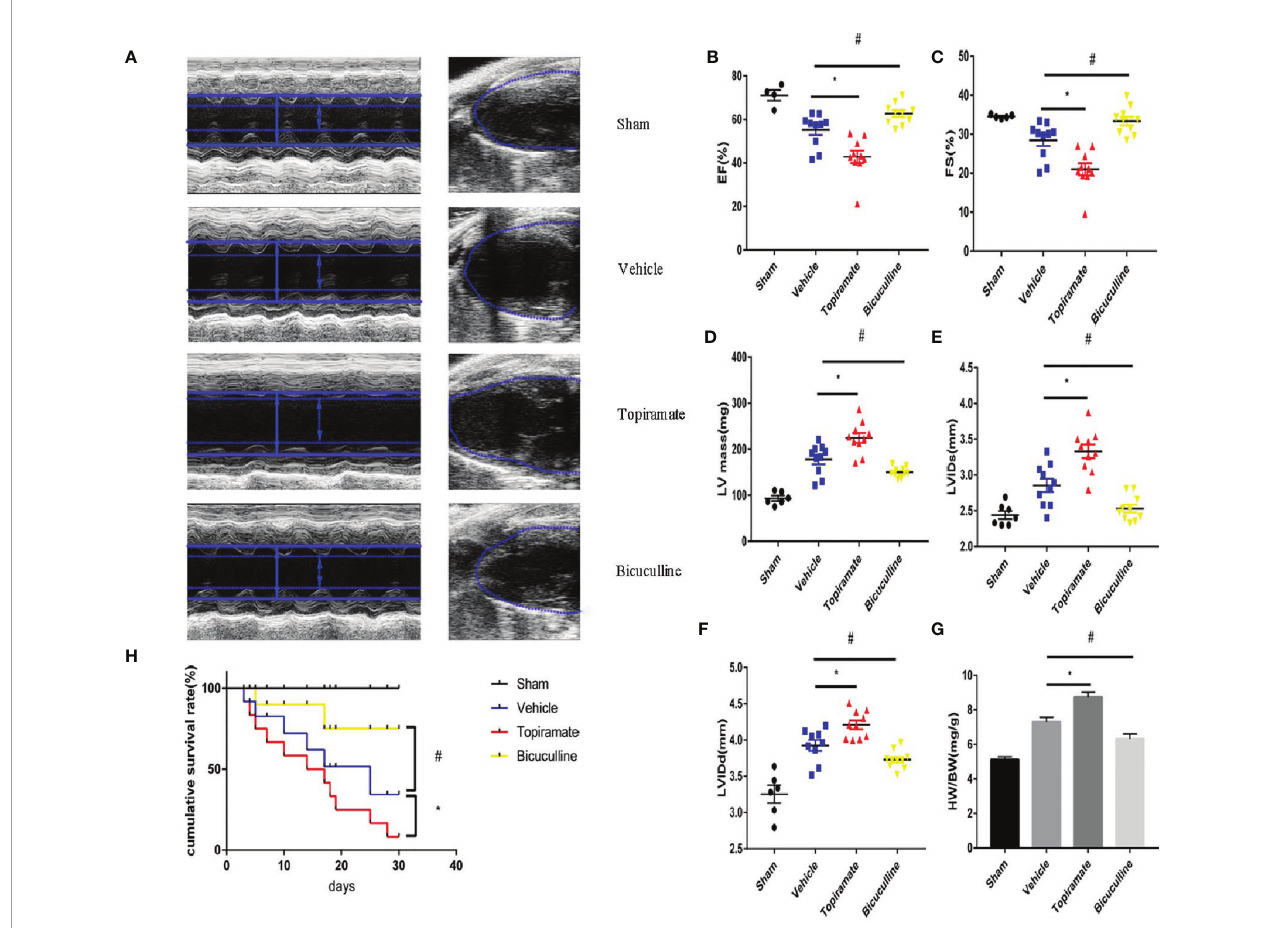
FIGURE 1 | Activation or blockade of the GABA A receptor aggravates or attenuates cardiac dysfunction in pressure-overload hypertrophy mice. Mice underwent sham or transverse aortic constriction (TAC) operation; mice in the TAC group were treated with intraperitoneal injections once a day of NaCl, topiramate or bicuculline for 3 weeks. (A) Representative left ventricular echocardiographic recordings at day 28 post-TAC. Short-axis M-mode (left) and long-axis B-mode (right). Arrows and lines marked (left ventricle internal dimension) LVID in systole (dashed) and diastole ( fi rm). (B) Ejection fraction (%EF), (C) fractional shortening (%FS), (D) left-ventricular mass (LV mass), (E) left ventricle internal dimension in systole (LVIDs), and (F) in diastole (LVIDd) in TAC- and sham-operated mice at day 28 post- TAC. (G) Heart weight/body weight (HW/BW) in indicated groups at day 28 post-TAC. Data showed the mean ± SEM of %FS, %EF, LV mass, LVIDd, LVIDs and HW/BW for each experimental group, by one-way ANOVA with Bonferroni ’ s multiple comparison test. (H) Compared with vehicle, the survival rate increased in bicuculline-treated TAC group during 30 days follow-up post-TAC (n = 20 in each group). For topiramate treatment, *P < 0.05 vs. vehicle. For bicuculline treatment, # P < 0.05 vs. vehicle. NaCl-treated TAC mice (for simplicity, vehicle). (n = 4 – 6 in sham group, n = 10 in TAC-operated